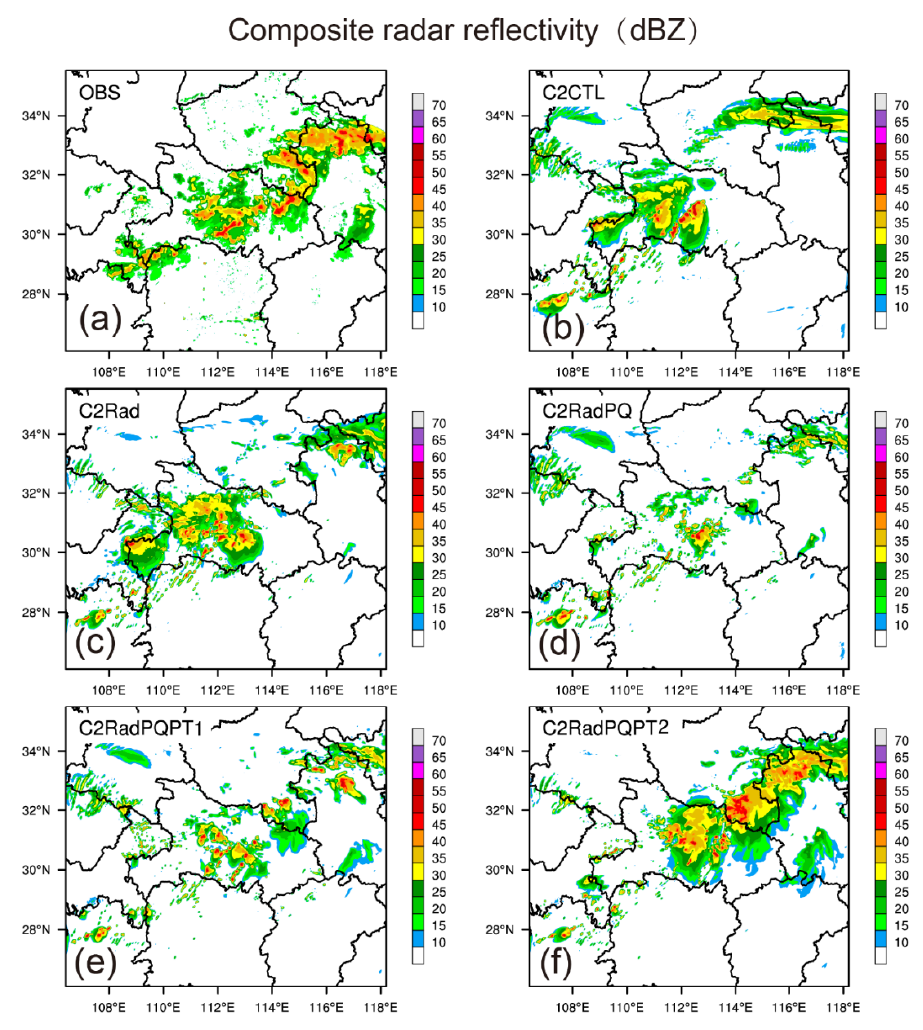
Figure 13. Same as in Figure 7, but for 3-h forecasted composite radar reflectivity (dBZ) launched at 1400 UTC (4 July, 2018).